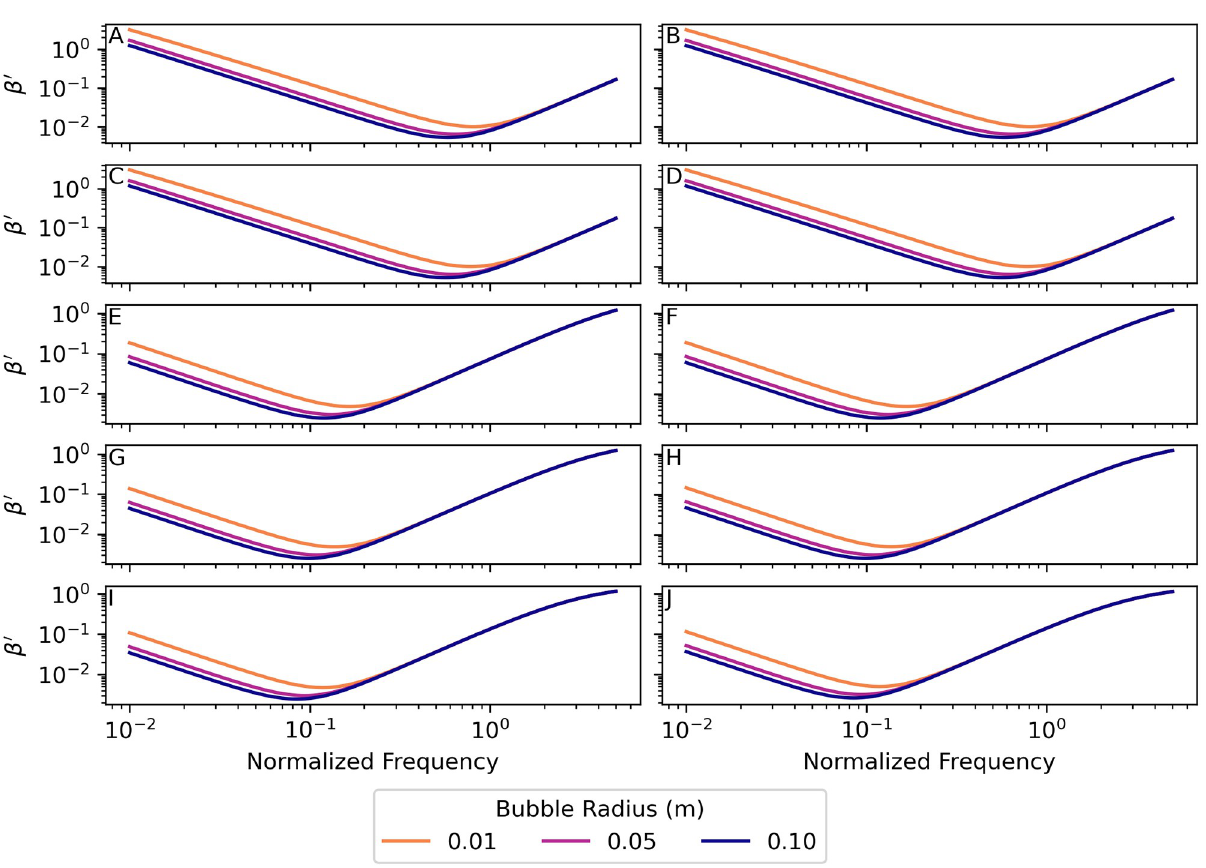
Fig 6. Normalized damping factor β 0 = β / ω und vs. normalized frequency f 0 for several bubble radii. Parameter values for each environment are given in Table 1. (A) Nitrogen bubbles in the warm-surface environment. (B) Oxygen bubbles in the warm-surface environment. (C) Nitrogen bubbles in the cold-surface environment. (D) Oxygen bubbles in the cold-surface environment. (E) Nitrogen bubbles in the 1000 m deep environment. (F) Oxygen bubbles in the 1000 m deep environment. (G) Nitrogen bubbles in the 2000 m deep environment. (H) Oxygen bubbles in the 2000 m deep environment. (I) Nitrogen bubbles in the 3500 m deep environment. (J) Oxygen bubbles in the 3500 m deep environment. See sections 8.8 and 8.9 in S3 and S4 Files for the calculations used for this plot.